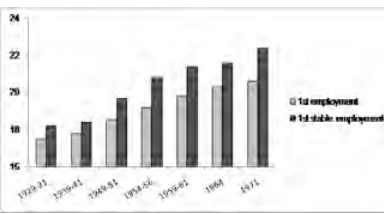
Figure 1: Median age (in years) at entering (stable) employment, by birth cohort